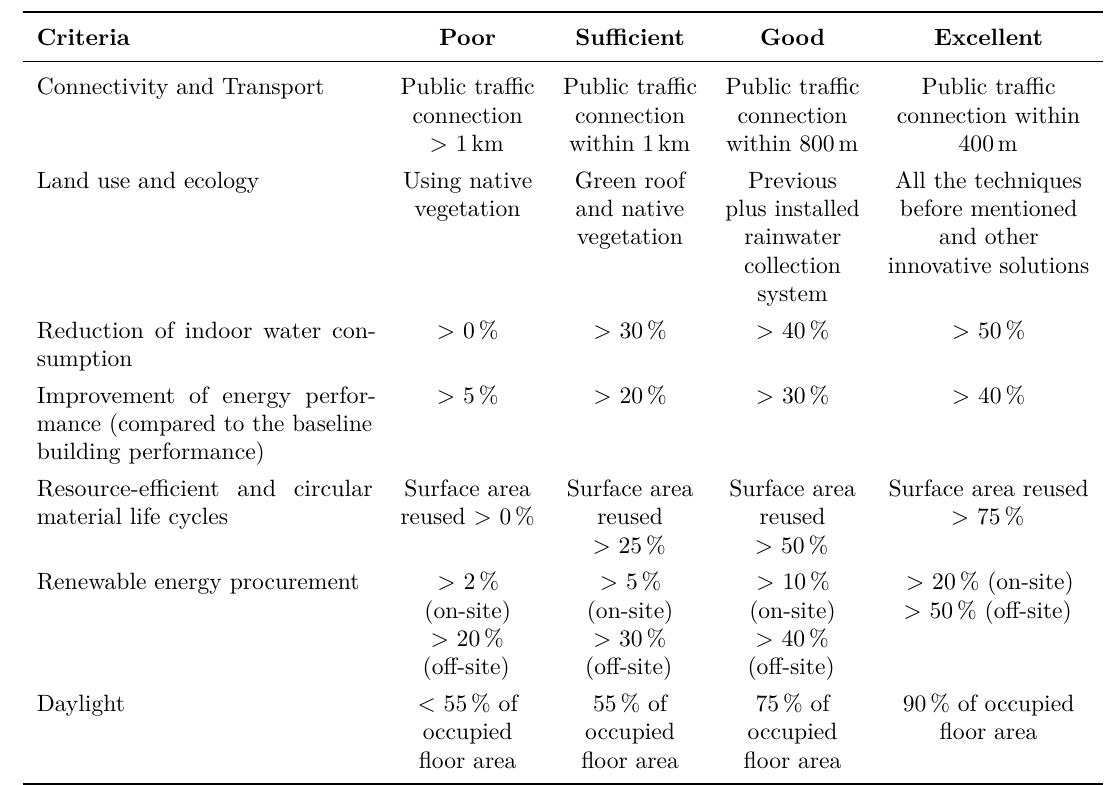
Table 1. Compilation of criteria for the evaluation of qualitative aspects related to sustainability.